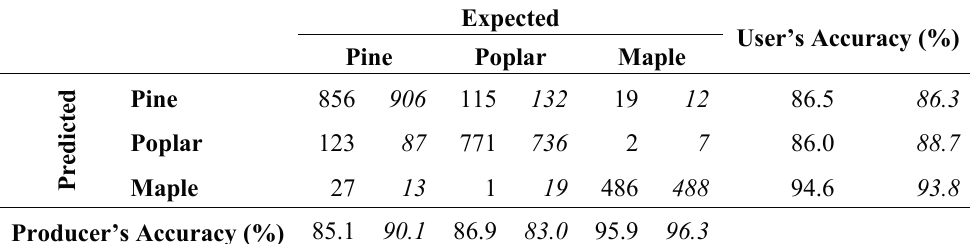
Table 4. Confusion matrix for individual classifier: bold number: geometric classifier (average accuracy of 88.0%); italic numbers: vertical profile classifier (average accuracy of 88.8%).